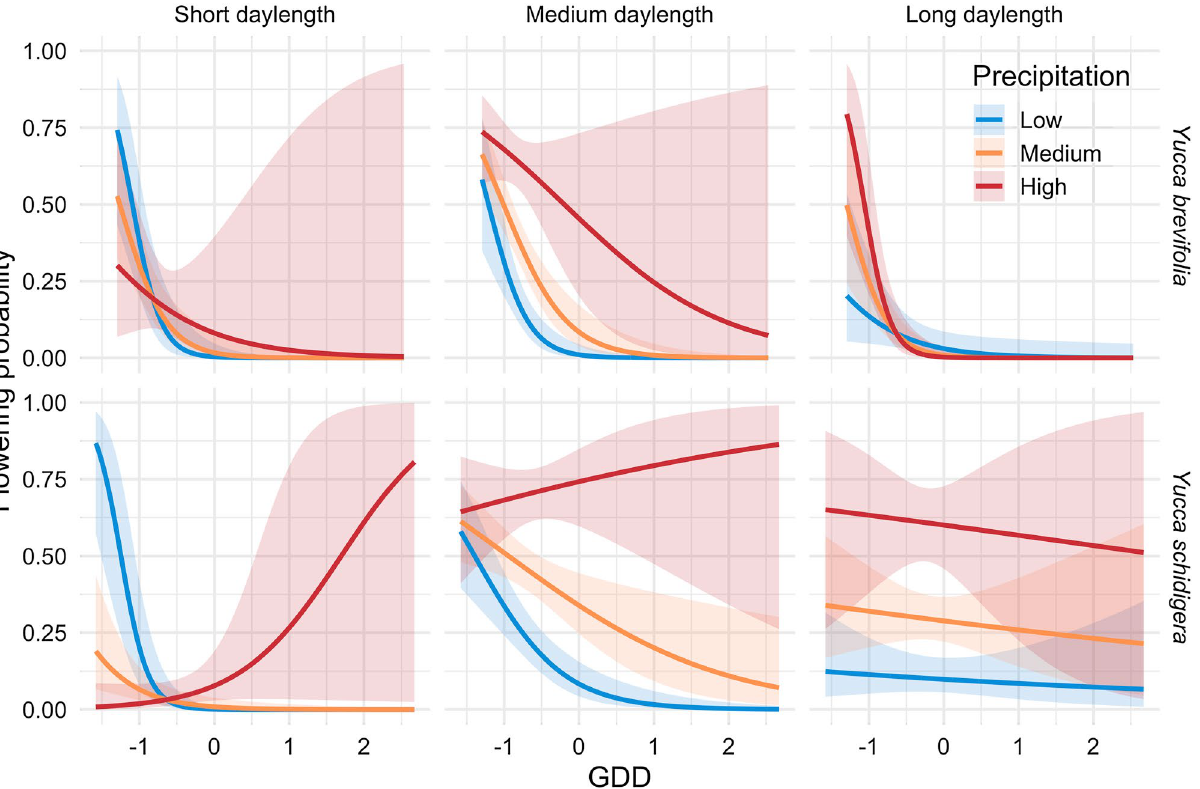
Figure 3. Predicted probability of flowering given scaled daylength, scaled GDD, and scaled average precipitation conditions for Yucca brevifolia (top panel) and Yucca schidigera (bottom panel).